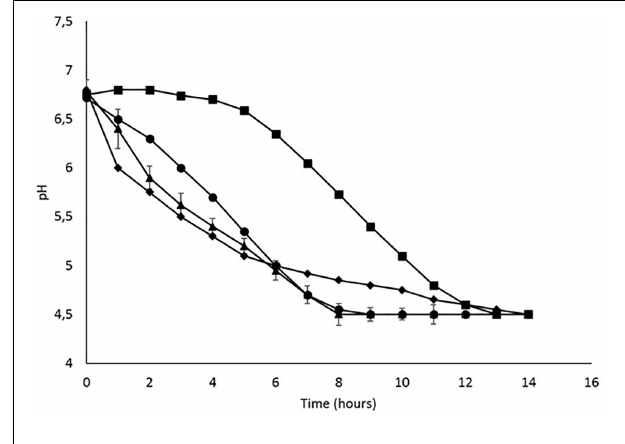
FIGURE 1 | Batch fermentation profile of ( • ) Ld. bulgaricus 2214, ( (cid:7) ) Ld . bulgaricus 147, ( (cid:78) ) W. minor 4451, and ( (cid:4) ) Lc. lactis 220, in SSM.